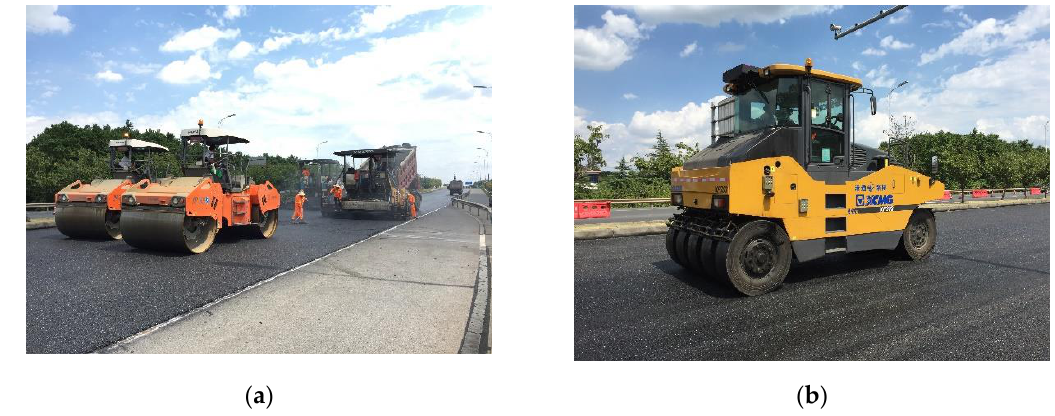
Figure 15. Compaction process: ( a ) Compaction by steel roller; ( b ) Compaction by rubber roller.